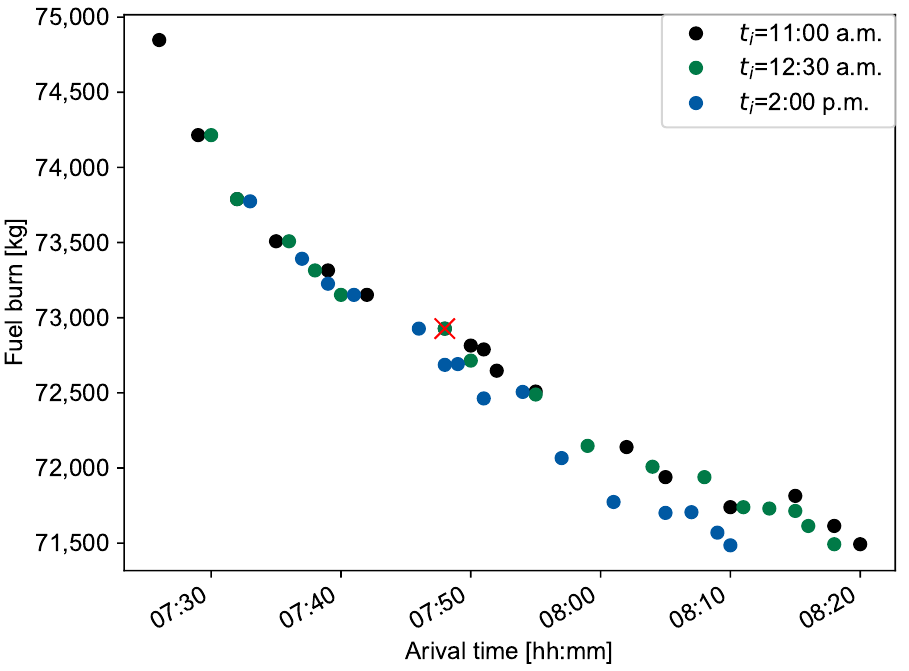
Figure 8. Fuel burn and arrival time of a B777 flight AFR256 from Paris Charles de Gaulle to WSSS. Cruising speed is changed from t i = 11.00 a.m. (black), t i = 12.30 a.m. (green) and t i = 2.00 p.m. (blue) between Mach 0.7 and 0.86 in steps of δ Mach = 0.01. The red cross indicates the reference cruising conditions with Mach